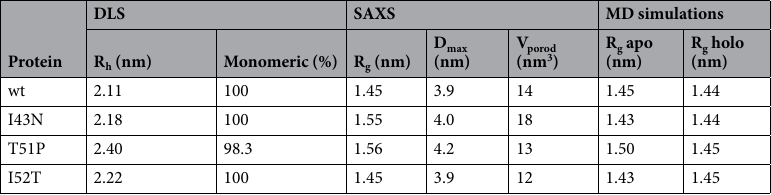
Table 1. DLS, SAXS, and MD simulation parameters.